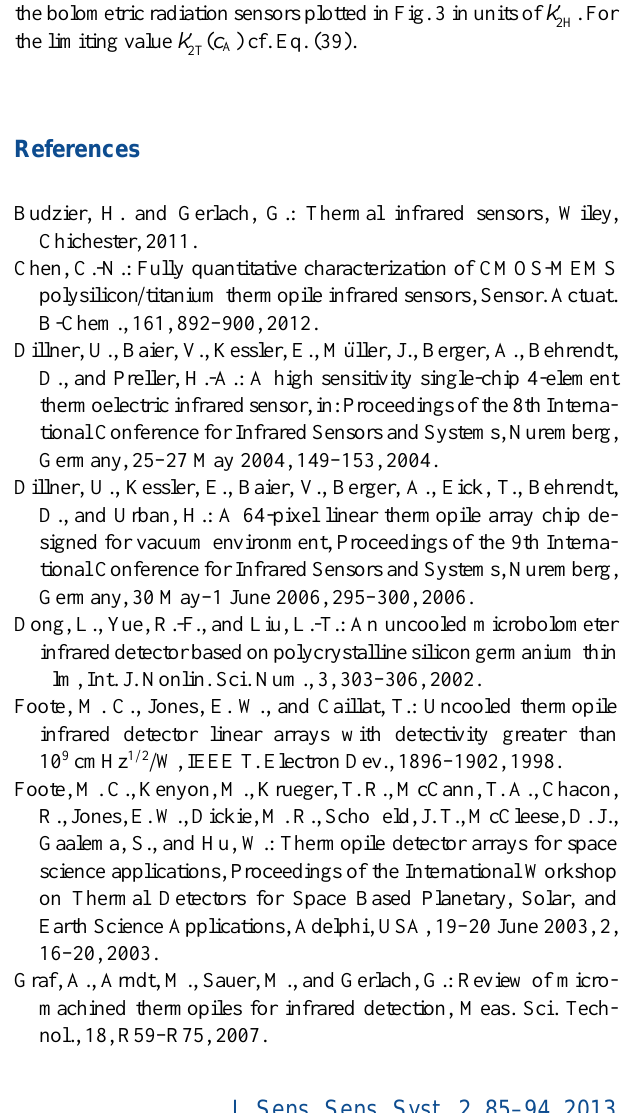
Figure 5. Dimensionless figure of merit M 2H measuring D ∗ / the bolometric radiation sensors plotted in Fig. 3 in units of k 0 the limiting value k 0